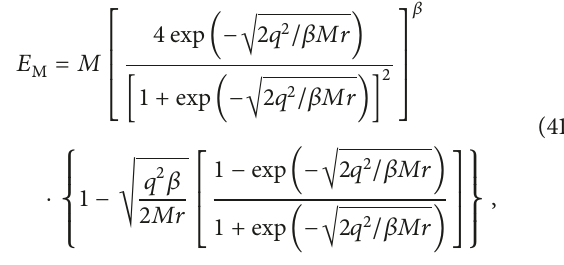
Figure 2: Energy distribution obtained in the Møller prescription for different values of 𝛽